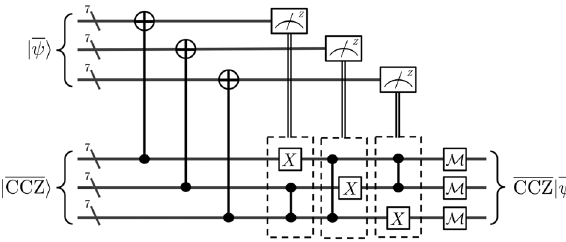
FIG. 12. Teleporting a CCZ gate into code blocks using a j CCZ i state verified using Fig. 11. All gates and measurements are transversal. Again, M is the measurement of all 7-qubit stabilizers using Steane states, Fig. 10(a). Assuming the classi- cally controlled operations are never done, the total circuit volume, the complete volume of magic-state injection with postselected preparation, is 969 þ 42 × 2 þ 155 × 3 ¼ 1518